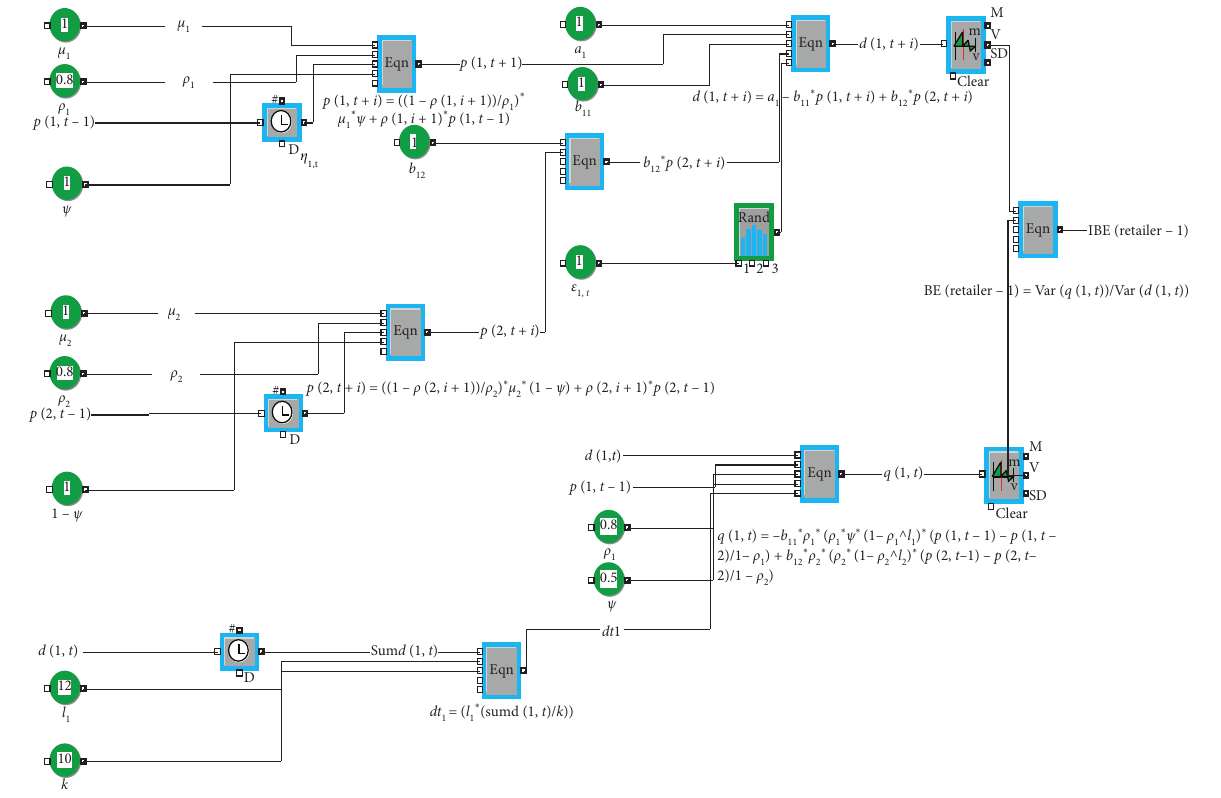
Figure 4: The simulation model of the bullwhip effect based on the MMSE